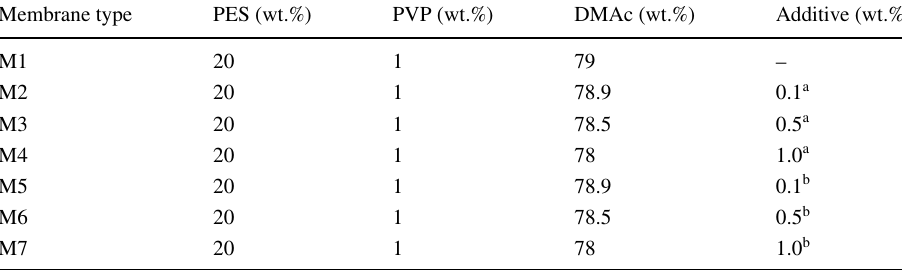
Table1 The casting solution composition for membrane